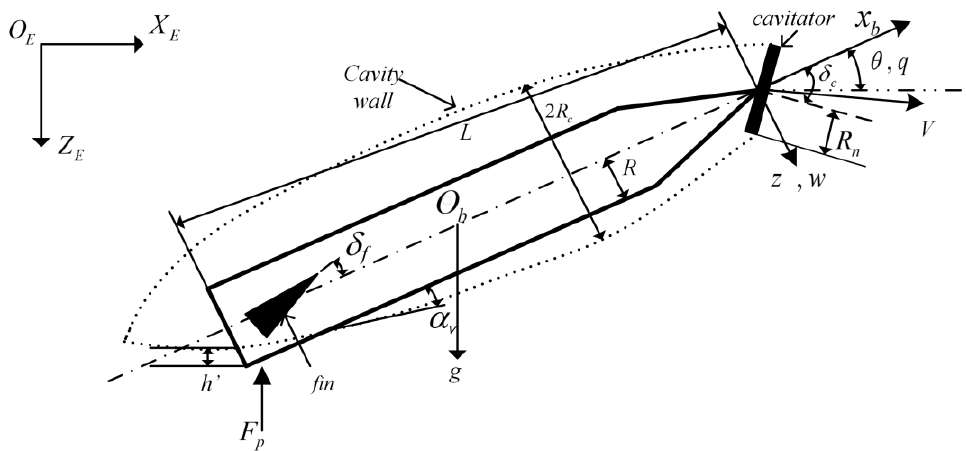
Figure 1. The configuration diagram of an HSSV.